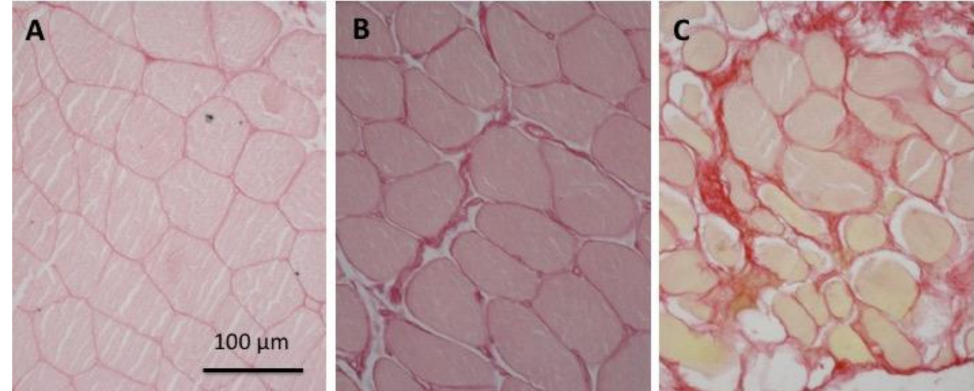
Figure 3. Increase of the relative area occupied by collagen and extracellular matrix (ECM) with age.